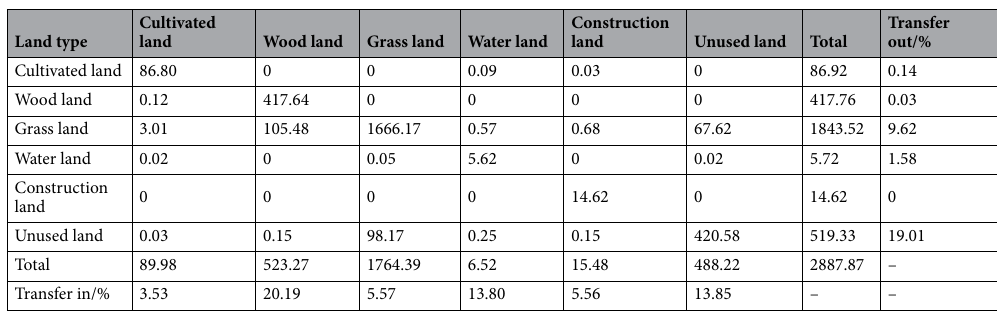
Table 2. 2016–2018 Land use area transfer matrix (km 2 ).